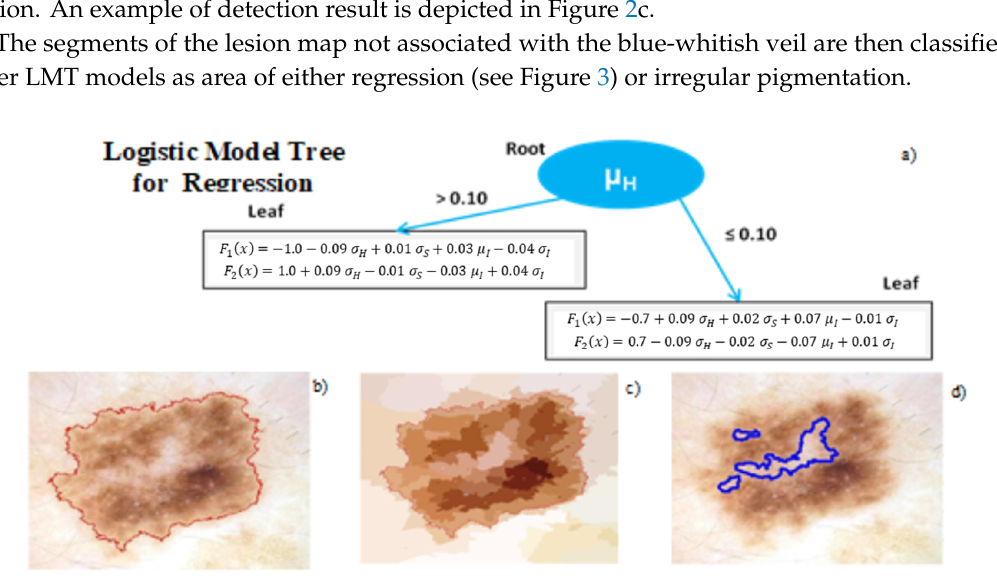
Figure 2. Detection of the blue-whitish veil: ( a ) Logistic model tree with regression models Fi(x) (with i = 1, blue-veil region, and i = 2, no blue-veil region); ( b ) lesion map (feature extraction); ( c ) regions classified as blue-whitish veil.